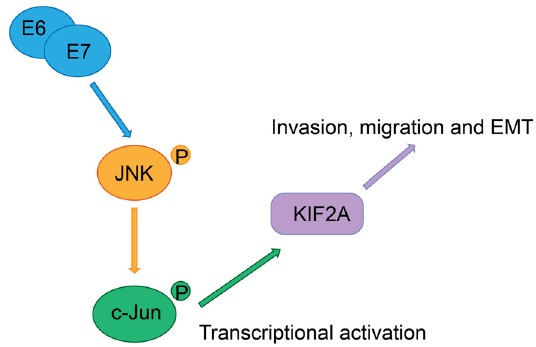
Figure 5: Signal pathways. KIF2A plays a key role in the invasion, migration, and EMT of cervical cancer cells. HPV16 E6/E7 can increase the levels of transcription factors c - Jun by activating the JNK signal, thereby up - regulating the transcriptional expression of